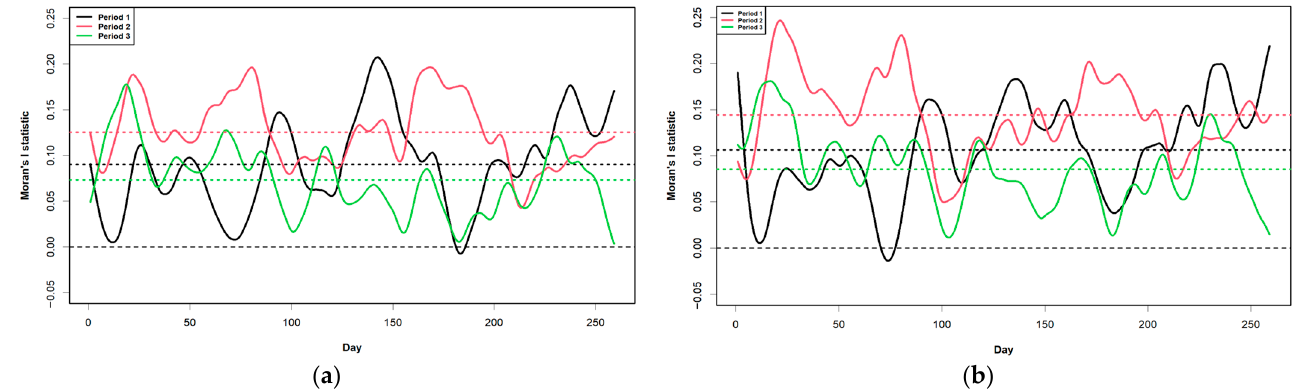
Figure 1. Functional Moran’s I statistic ( a ) calculated using KNN connection network and ( b ) calcu- lated using Gabriel graph-based connection network.